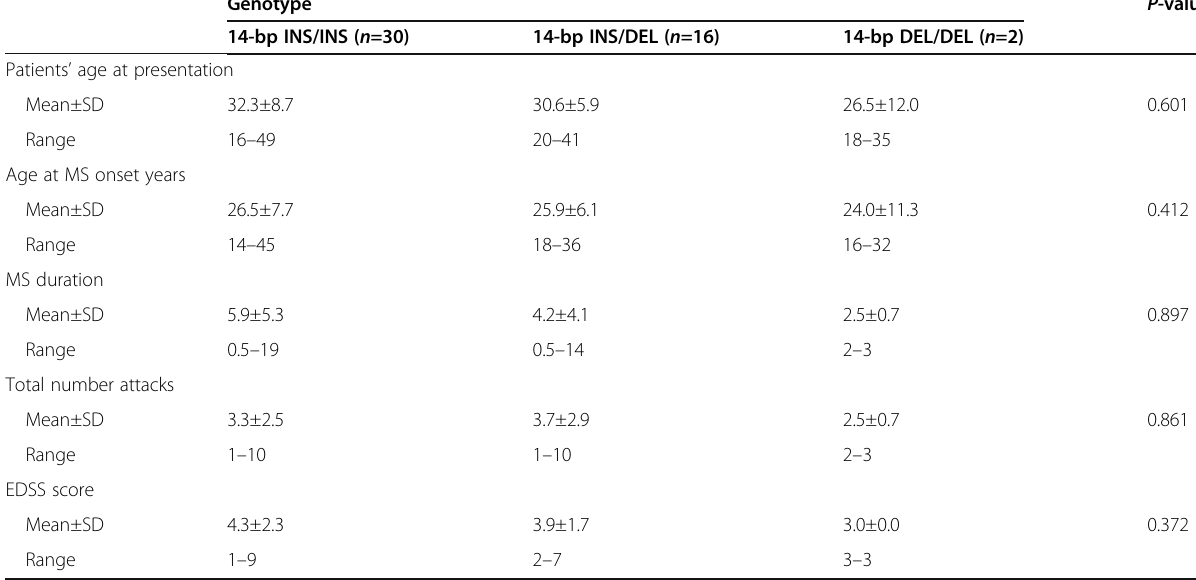
Table 4 Relation of 14-bp insertion/deletion polymorphism genotype to clinical, laboratory, cognitive, and psychological assessment of MS